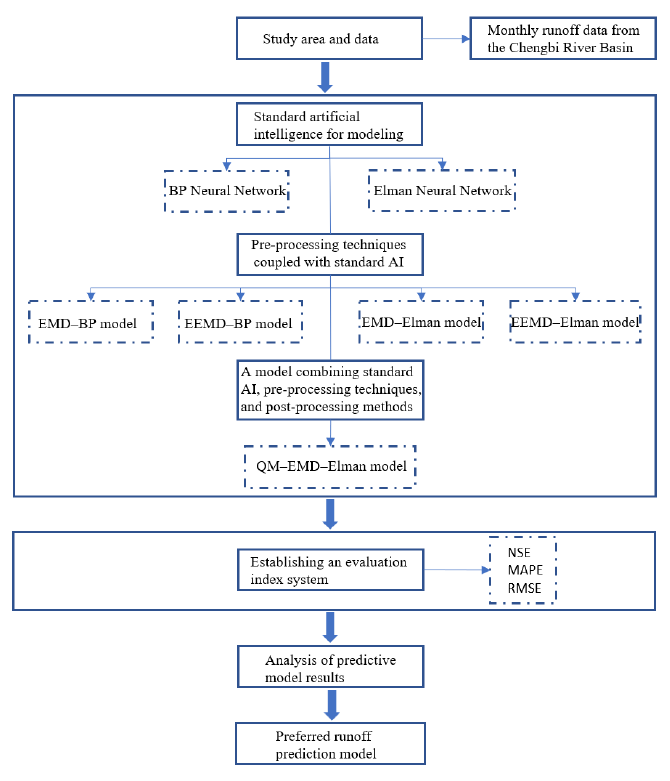
Figure 2. Flowchart of the research in this study.